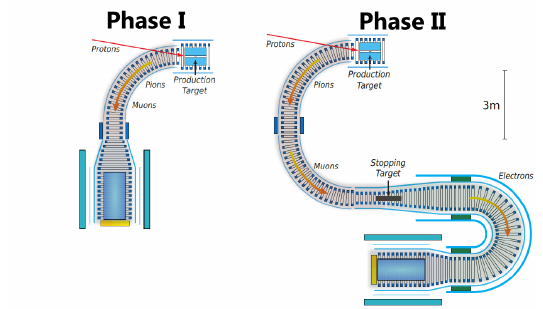
Figure 1. The schematic layout of the COMET experiment.